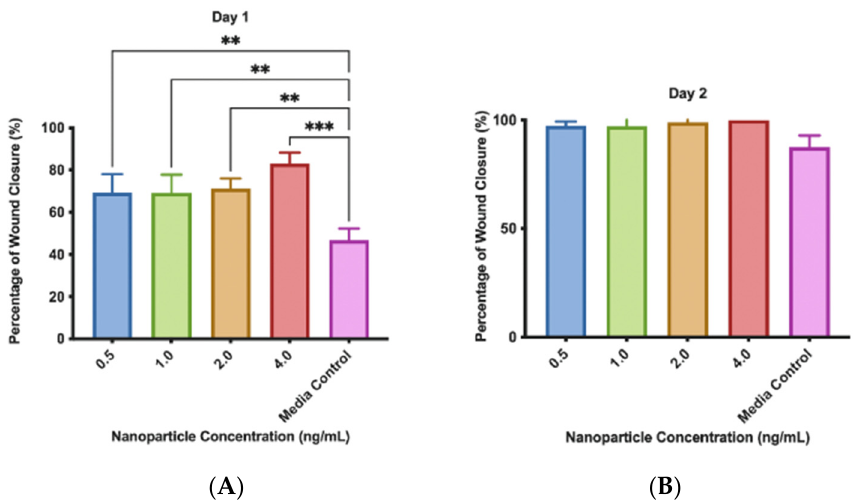
Figure 9. Scratch assay results. Fibroblasts supplemented with MMSC ECM nanoparticles have a faster wound closure rate compared to the media control. ( A ) Fibroblast growth rate after 24 h with nanoparticle media. ( B ) Fibroblast growth rate after 48 h with nanoparticle media. The data displayed are the mean ± standard deviation. ** indicates p < 0.001, *** indicates p < 0.0001, N = 3.